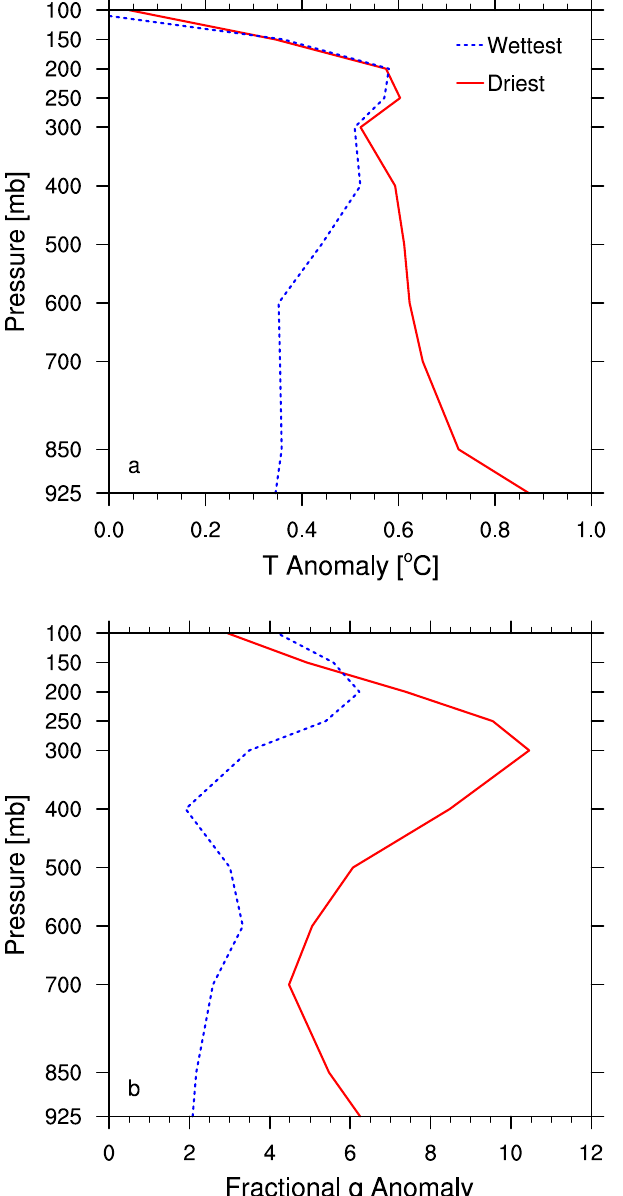
Figure 7. Zonal mean annual anomalies in 2010 for ( a ) T (°C) and ( b ) q (%) as a function of pressure (mb) over the driest and wettest from the 12 large-scale climate zones classified by precipitation. The anomalies are calculated as the difference in the annual averages in 2010 and the climatology aggregated from other years (2003–2009 & 2011–2015). For the q plot, the anomaly is expressed as the percentage divided by the climatological q